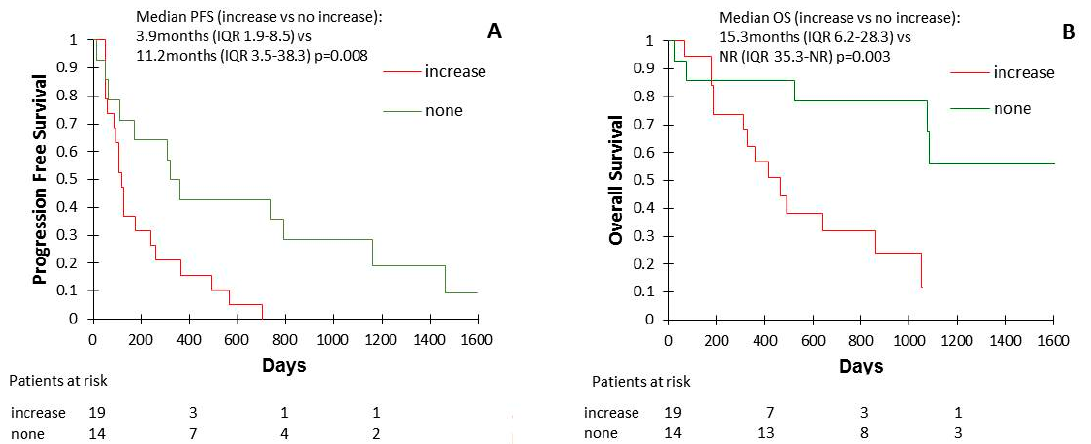
Figure 3. Progression-free survival (PFS) ( A ) and overall survival (OS) ( B ) according to the evolution of plasma Wnt1 concentrations during ICI treatment.